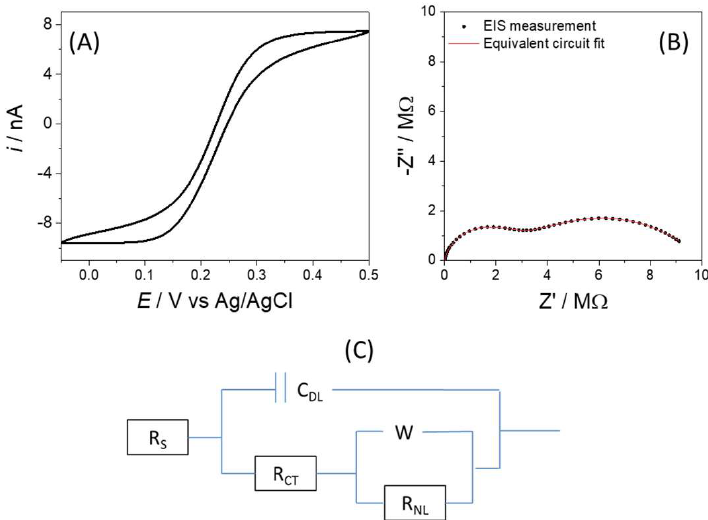
Figure 3. ( A ) CV and ( B ) (EIS) from a 50 µm electrode on the chip which was immersed in 1 mM potassium ferri-ferro cyanide + 1 mM potassium chloride + 100 mM potassium nitrate. Scan range—0.05 to 0.5 V and scan rate 0.02 Vs − 1 . EIS performed at open circuit potential. ( C ) Modified Randles’ equivalent circuit for EIS response of a microelectrode.